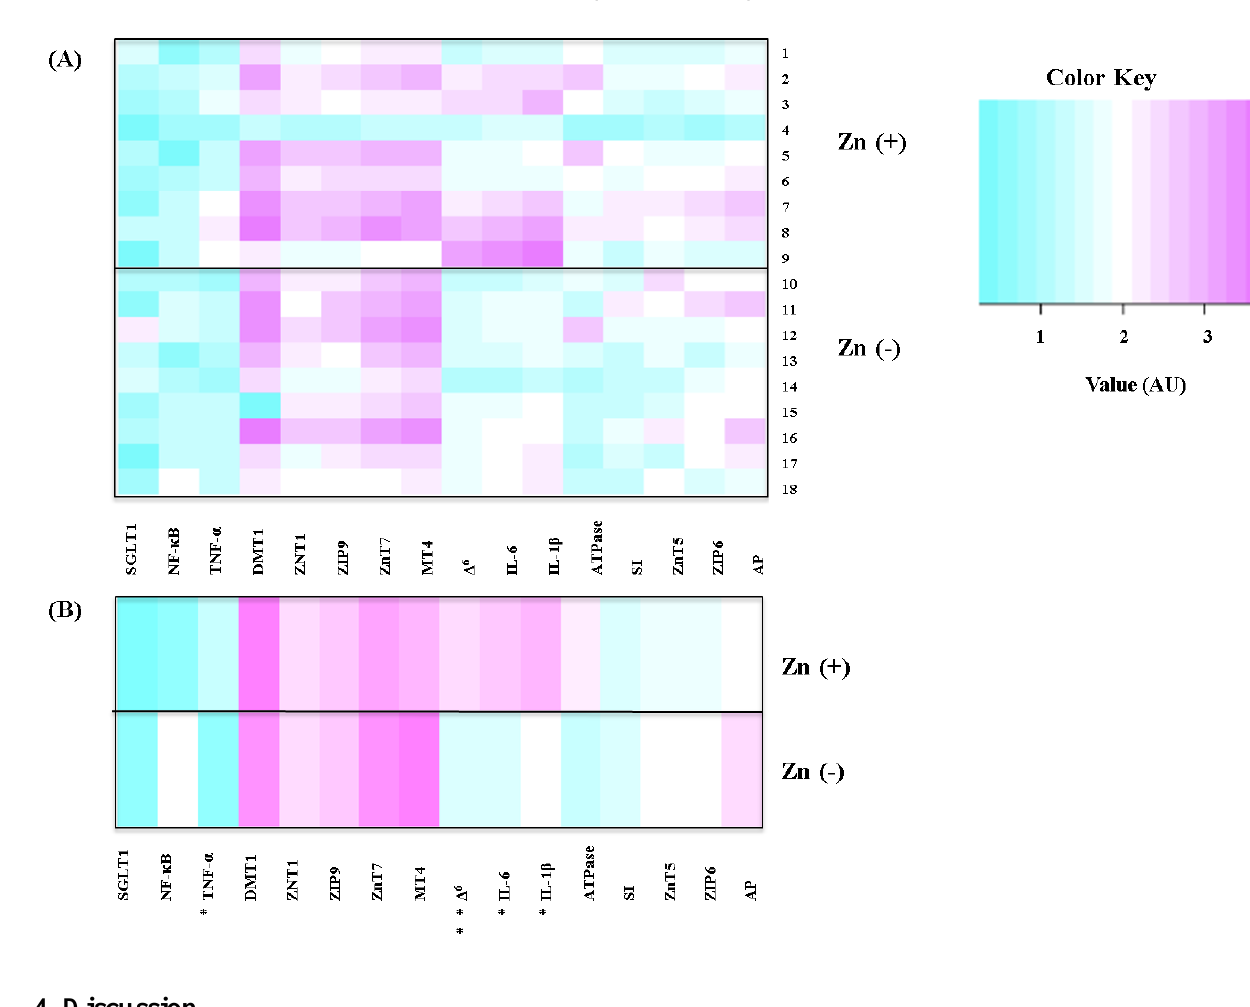
Figure 3. Intestinal (duodenal) and hepatic mRNA expression of zinc-related genes (day 28); changes in mRNA expression are shown relative to expression of 18S rRNA in arbitrary units (AU, n = 9). ( A ) Effect of zinc deficiency on gene expression. Treatment groups are represented as Zn(+) control: birds 1–9, and Zn(−): birds 10–18. Treatment groups are represented on the y -axis, and zinc related genes on the x -axis. ( B ) Mean effect of zinc deficiency on gene expression (* p < 0.05, ** p <